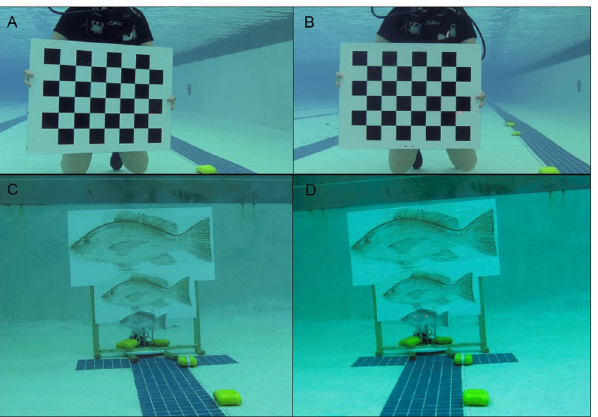
Fig 2. Paired images of calibration checkerboard and fish models. Example paired images from A) left or B) right view of calibration checkerboard (457 x 610 mm; 63.7 mm square size; 2 m distance) and C) left or D) right stereo camera view of fish display board indicating small (288 mm FL), medium (552 mm FL), or large (890 mm FL) paper red snapper models viewed at 3 m distance and perpendicular to the ROV. Laser points are visible on the smallest red snapper model in panels C and